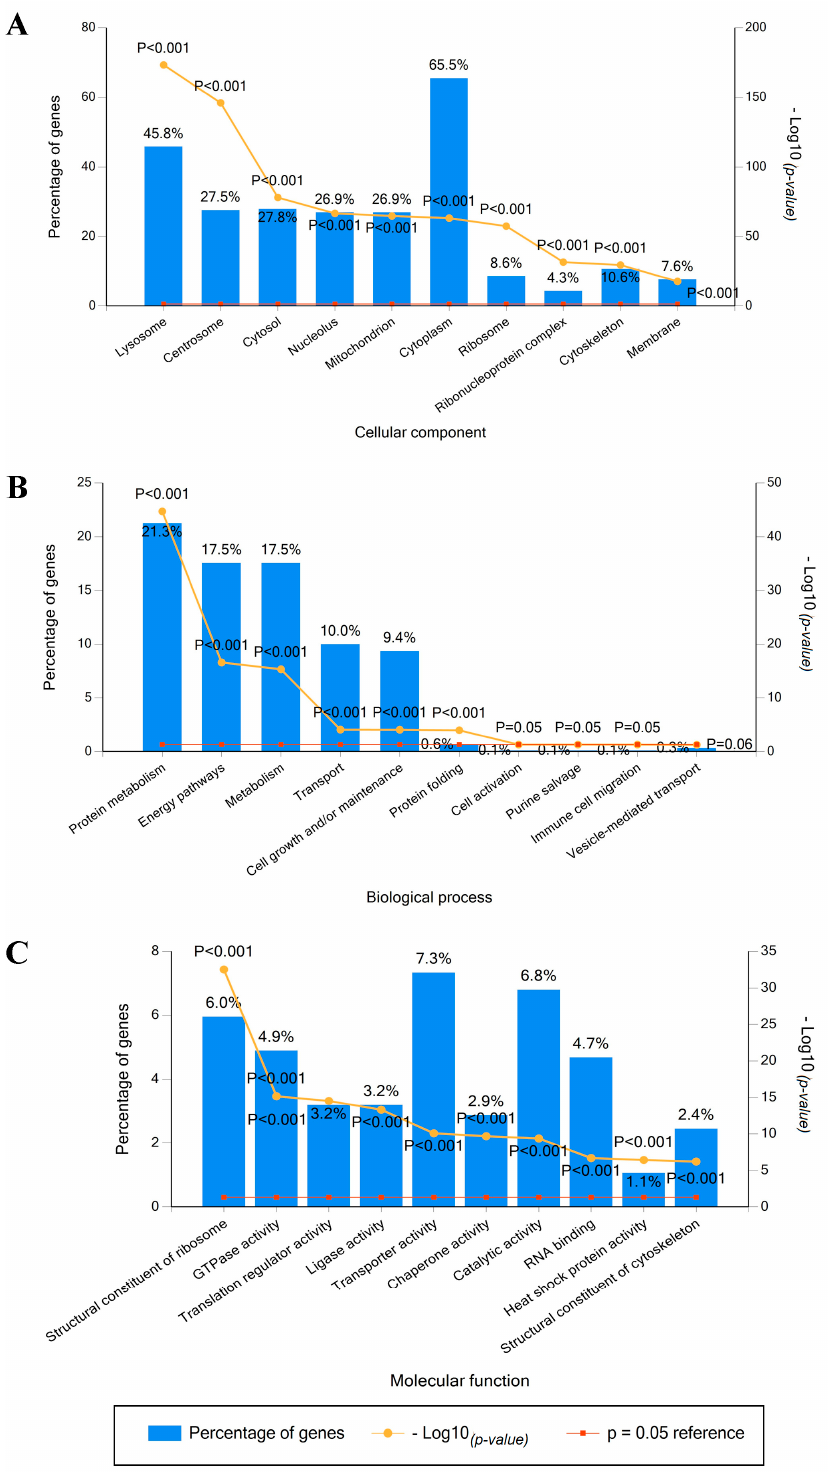
Figure 3. Gene ontology analysis of Mel202-derived ectosomal proteins using the FunRich gene database. Proteins were grouped according to the cellular compartments of their origin ( A ), involvement in different biological processes ( B ), and molecular functions ( C ). In each case, the ten most abundant groups (according to the percentage of assigned proteins) were presented on each graph. The p -value depicts the statistical significance of protein enrichment within the given categories.